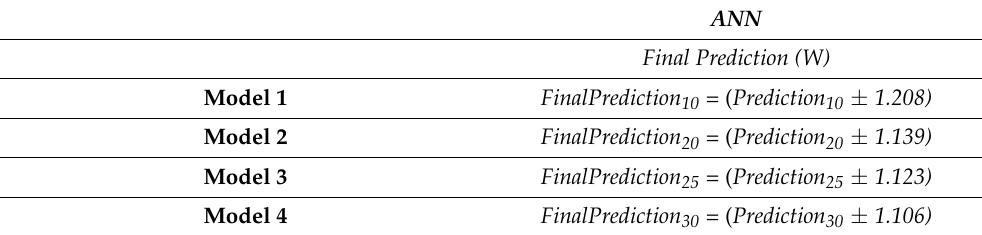
Table 15. Final prediction equations for Models